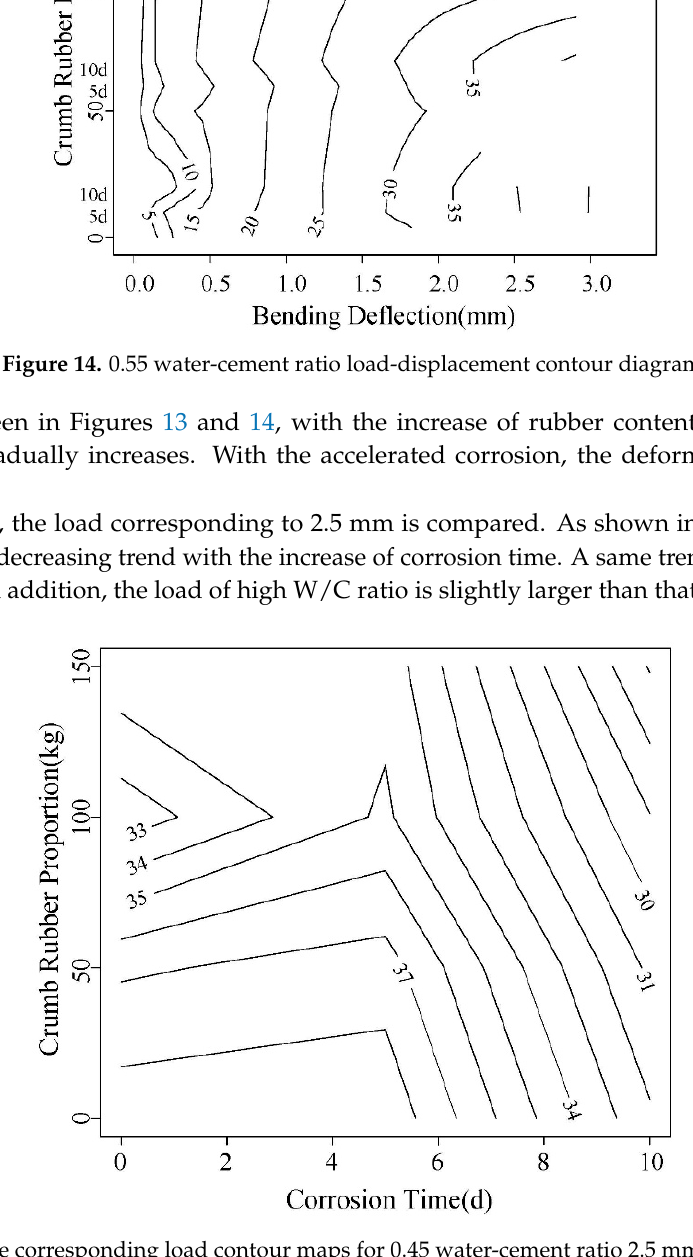
Figure 13. 0.45 Water-cement ratio load-displacement contour diagram.